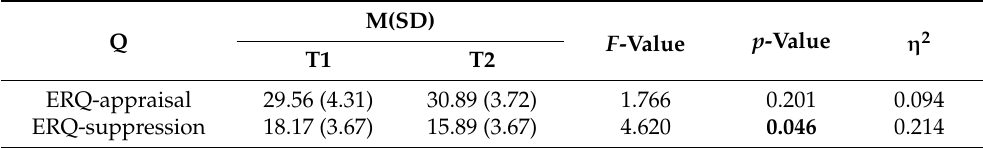
Table 3. Statistical comparison results of pre- (T1) and post-intervention (T2) for post-experiment emotion regulation questionnaire